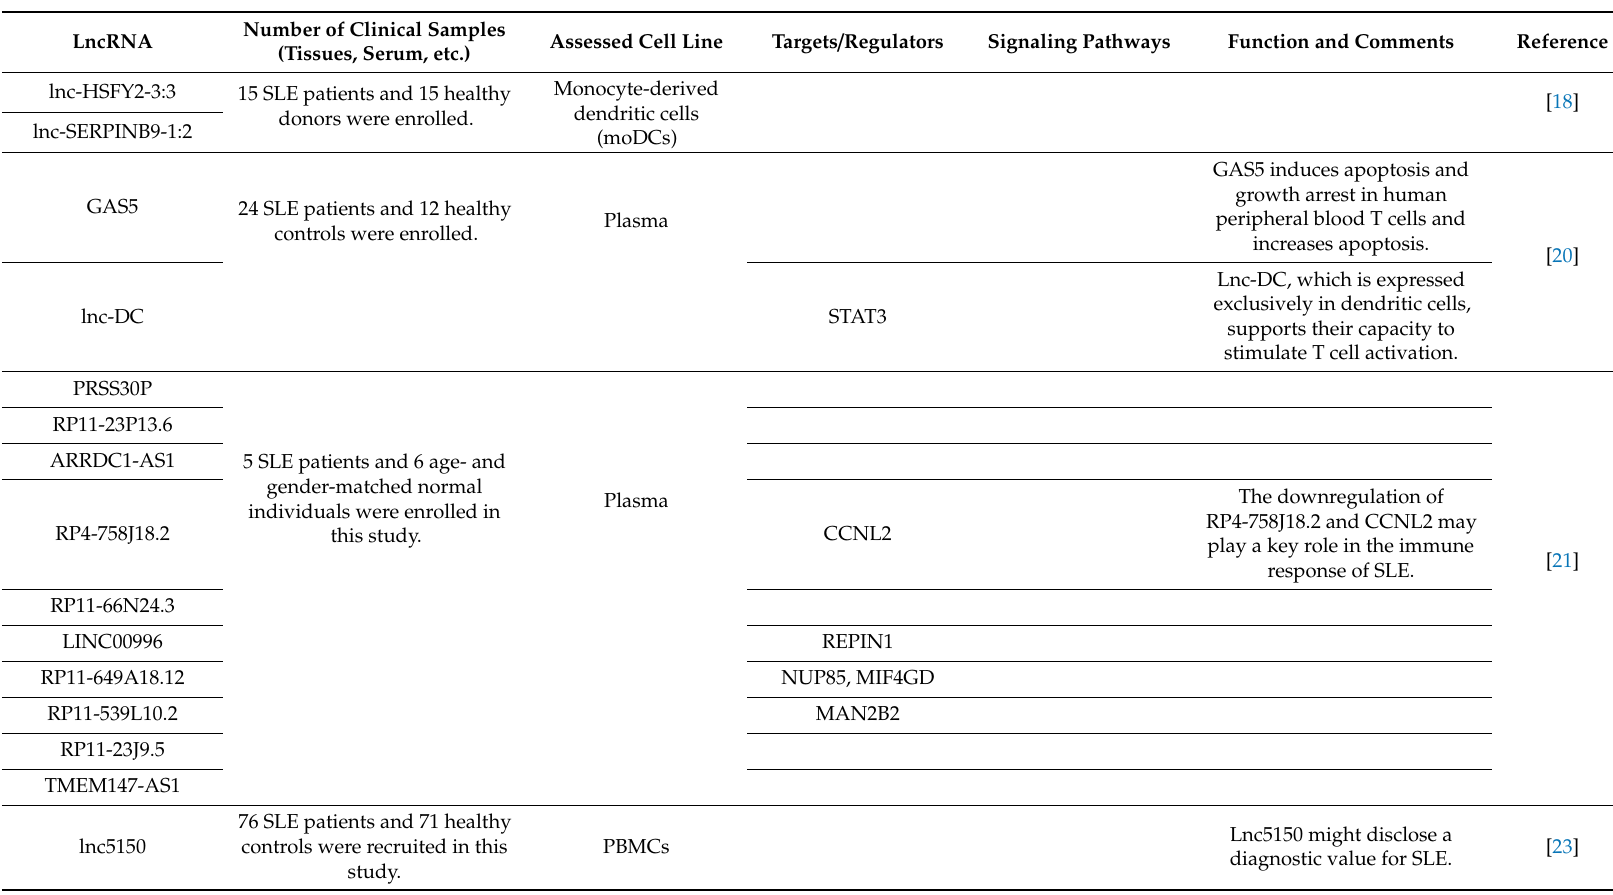
Table 1. List of lncRNAs whose expression has been downregulated in SLE patients (PBMC: peripheral blood mononuclear cell, SPF BALB / c mice: specific pathogen-free (SPF) bcl-2 transgenic BALB / c